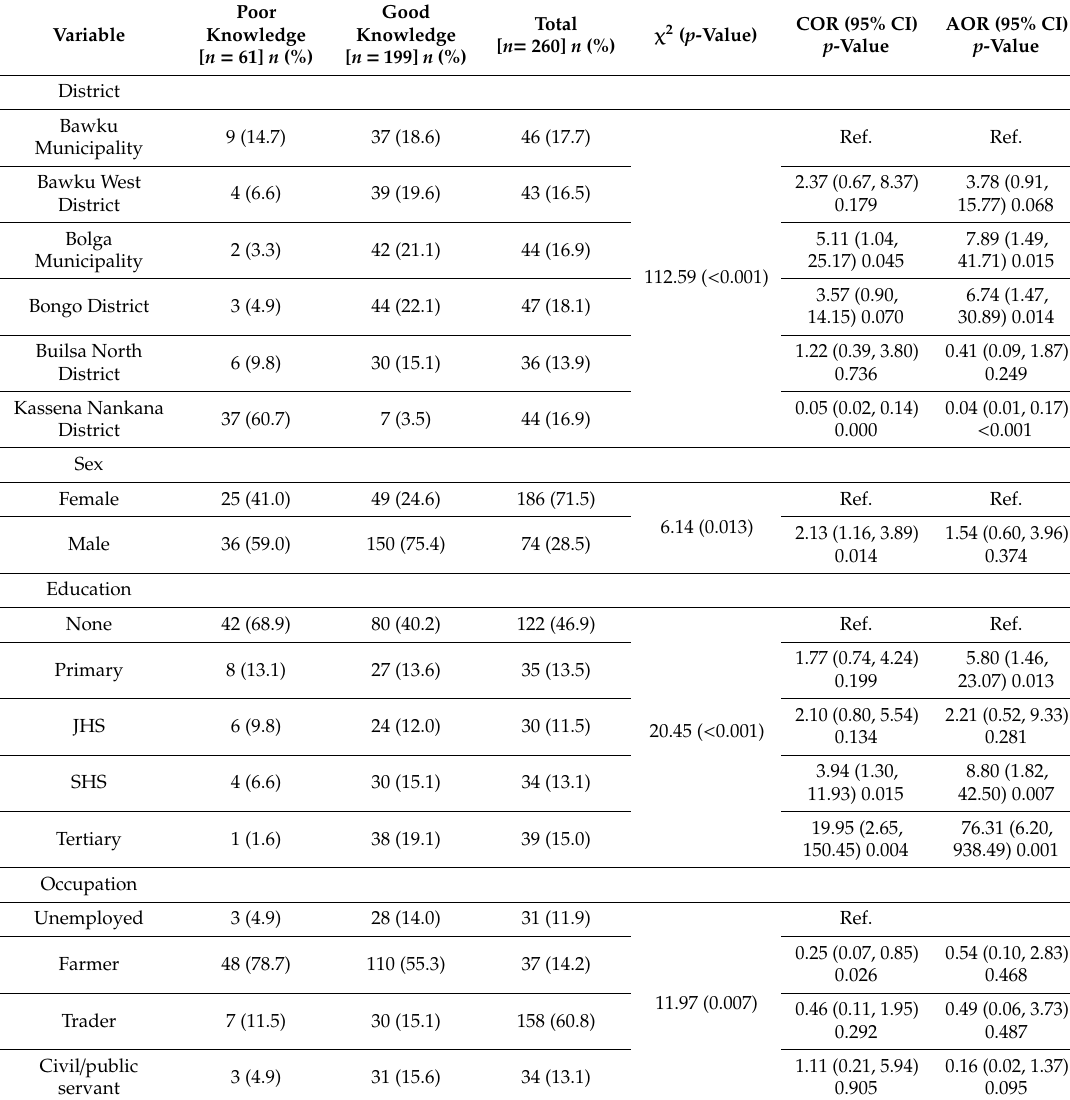
Table 3. Association between socio-demographic characteristics and knowledge about